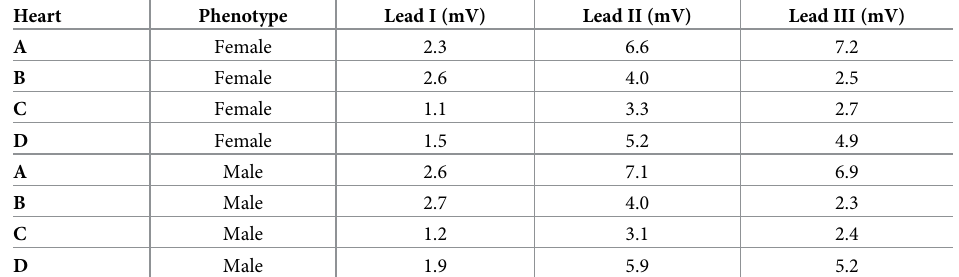
Table 3. Root mean square difference between the pseudo-ECG waveform of the detailed- and smoothed-geome- try simulations on both female and male sex phenotypes. Heart